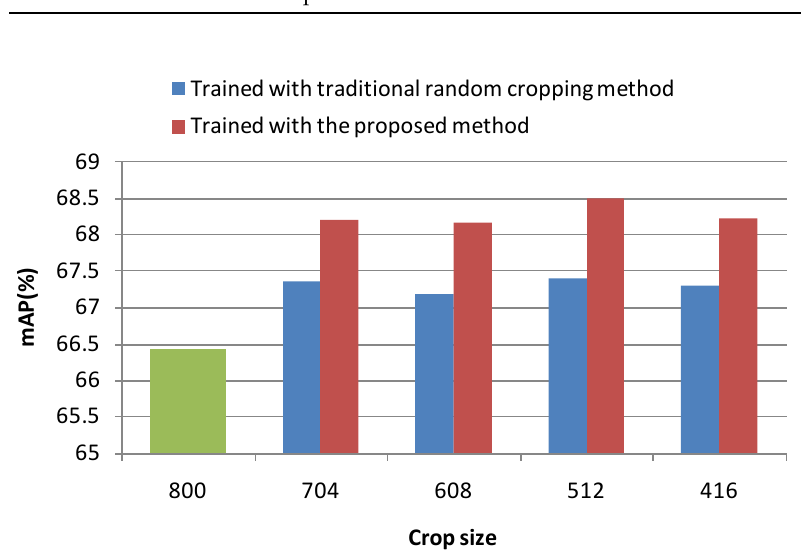
Figure 9. mAP of different models under different random crop sizes.